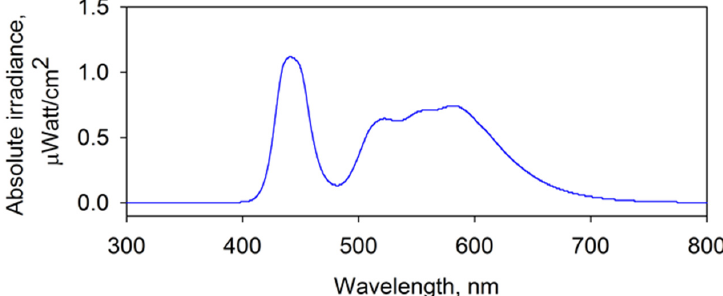
Figure 2. Spectrum of the fluorescent light source used for photocatalytic testing (with UV filter).